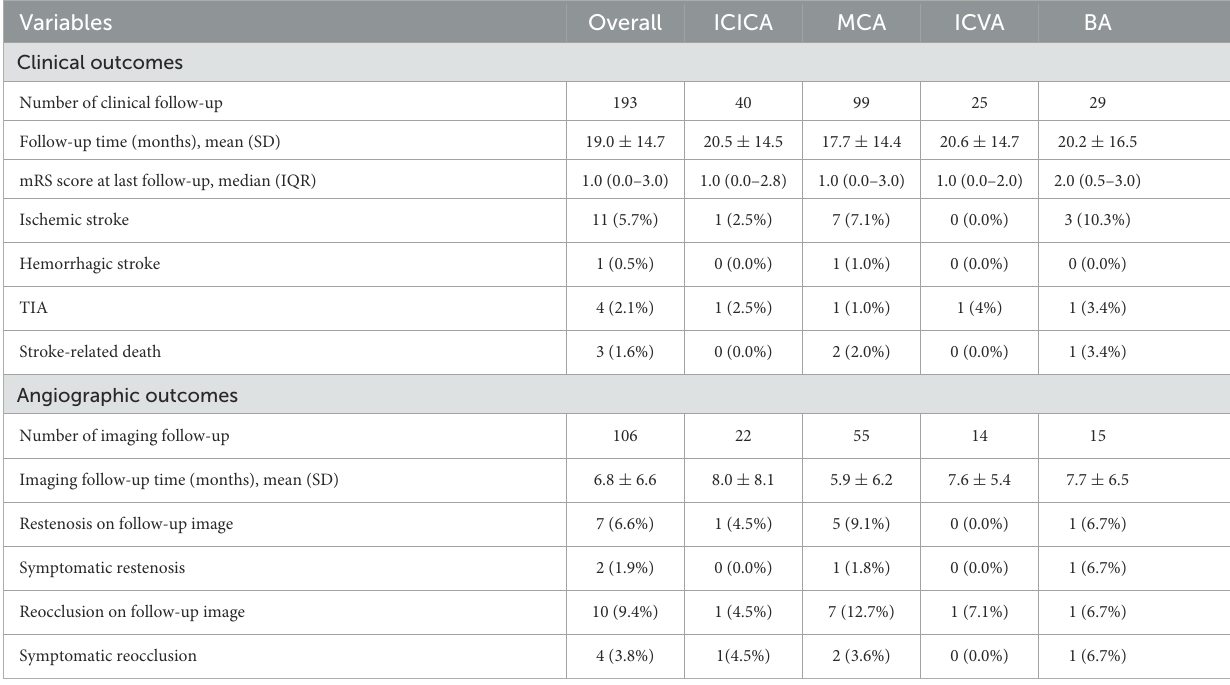
TABLE 3 Follow-up clinical and angiographic outcomes of successfully treated patients. Variables Overall ICICA